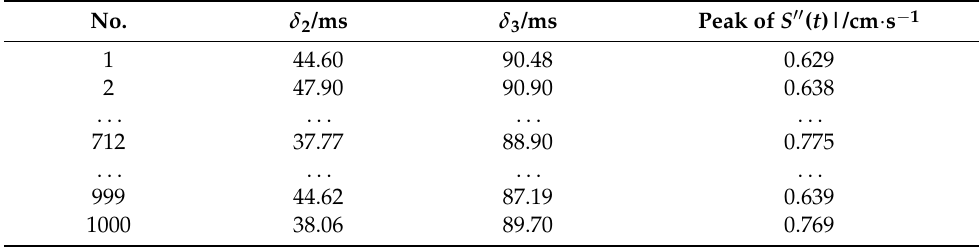
Table 1. The results of solving for the maximum value of vibration velocity when the charge amount was 1.0 kg in a single